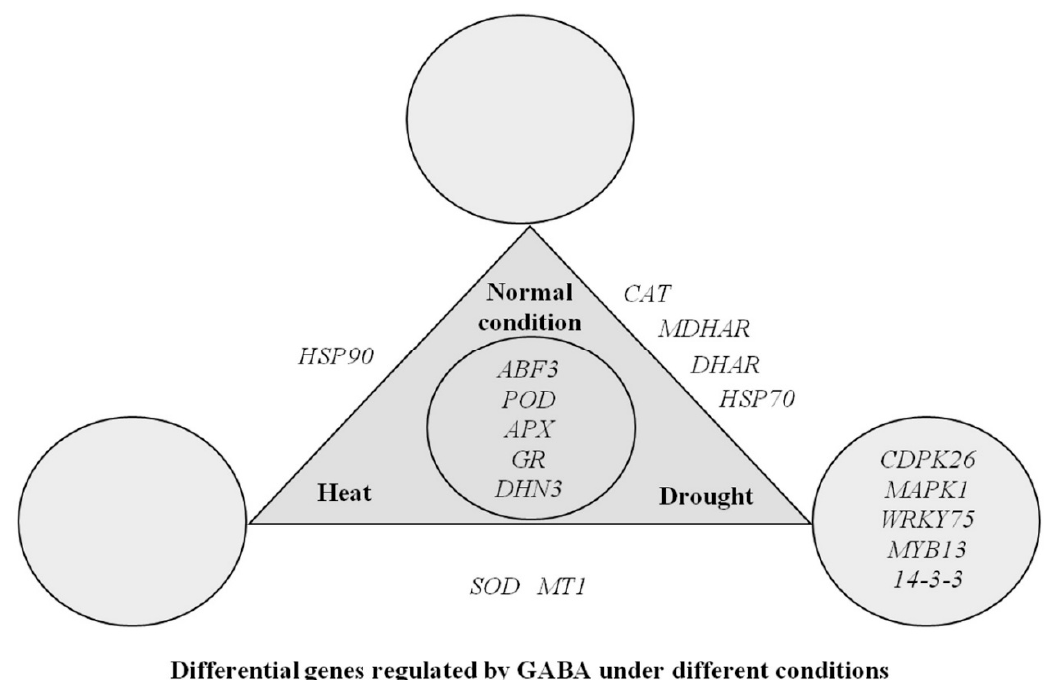
Figure 8. Effects of γ -aminobutyric acid (GABA) on genes’ expression of ( A ) heat shock protein 70 ( HSP70 ), ( B ) heat shock protein 90 ( HSP90 ), ( C ) dehydrin 3 ( DHN3 ), and ( D ) metallothionein 1 ( MT1 ) under normal, heat, and drought conditions. Vertical bars indicate ± SE of mean ( n = 4). Different letters above columns indicate significant differences for one particular treatment (control or +GABA) under different conditions; asterisk “*” indicates significant difference between control and +GABA treatment under a given condition.